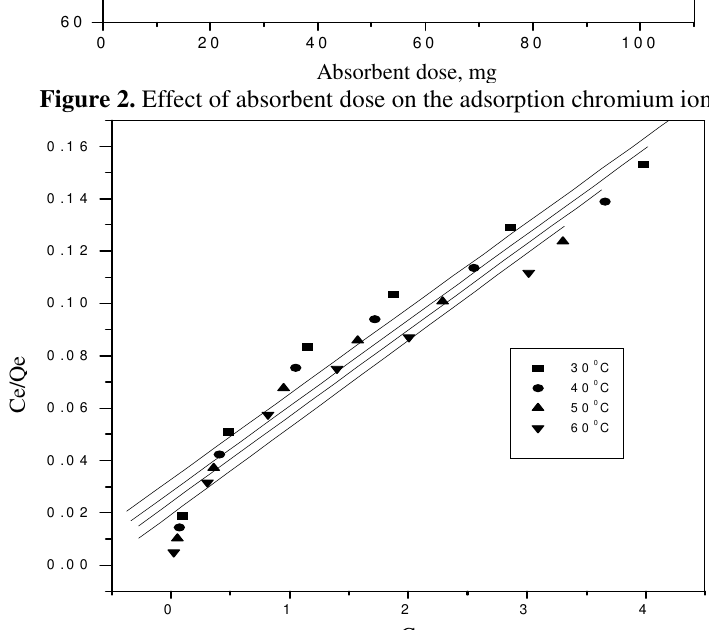
Figure 3. Langmuir adsorption isotherm for the adsorption of chromium